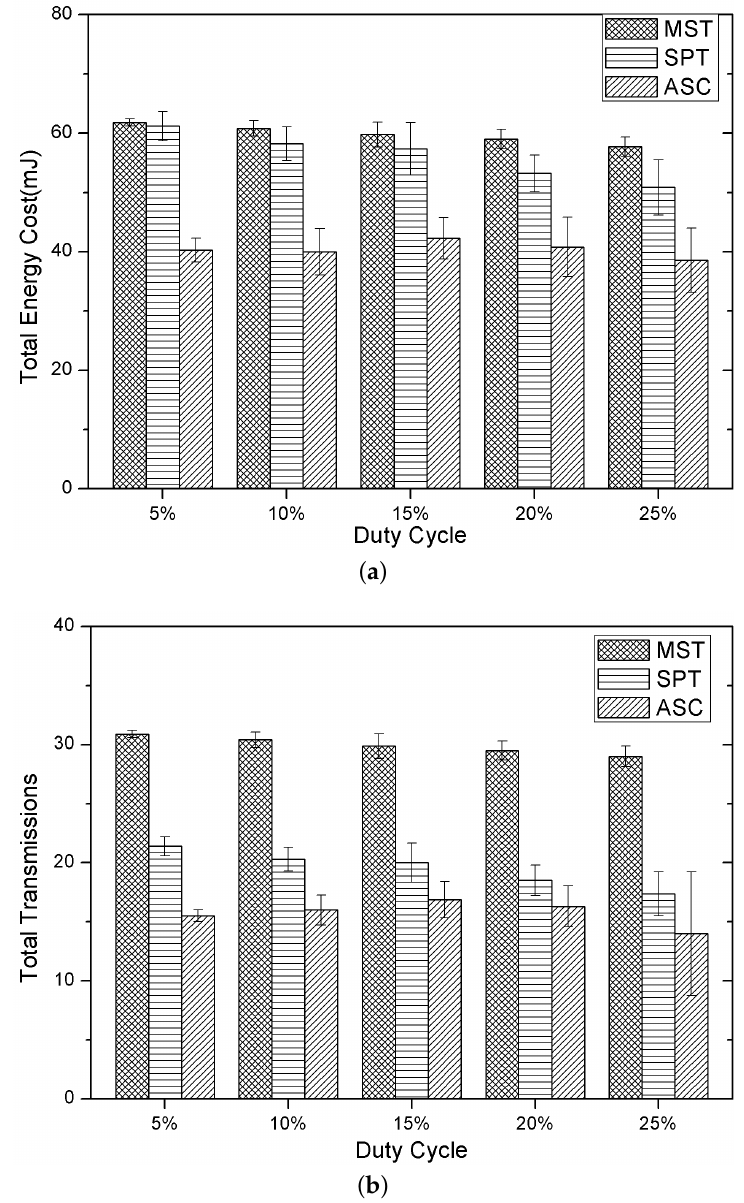
Figure 5. Performance under different duty cycles. ( a ) Total energy cost; ( b ) Total